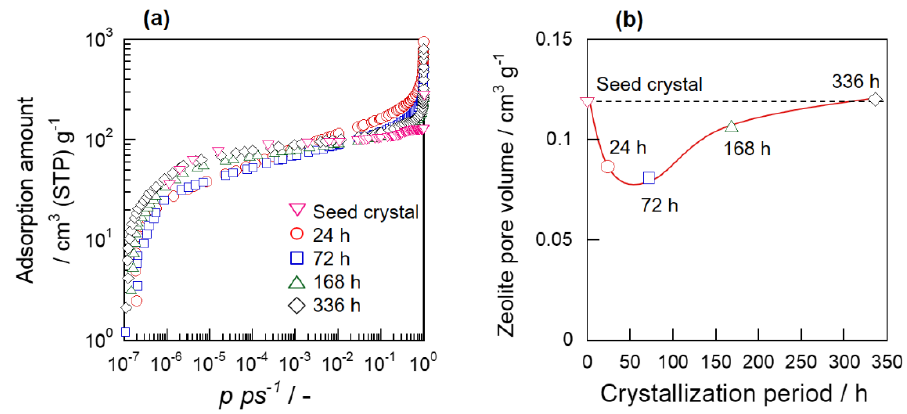
Figure 3. Results of non-destructive N 2 adsorption test: ( a ) isotherm and ( b ) zeolite pore volume change. ▽ , Seed crystal; membranes crystallized for , 24; , 72; △ , 168; ◇ , 336 h.